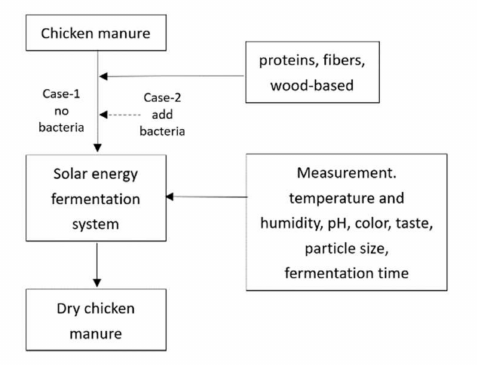
Figure 8. Flow chart of solar fermentation